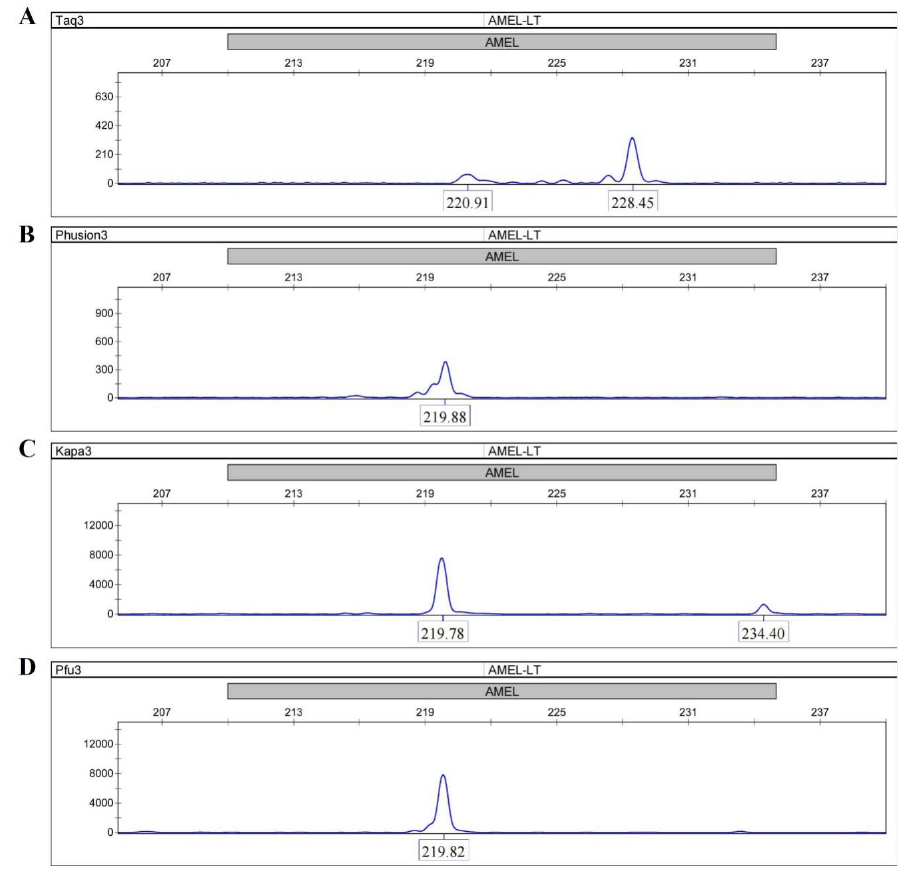
Figure 2. Extensions of TaC primers by the Phusion, Taq, KAPA and Pfu DNA polymerases. ( A ) Taq; ( B ) Phusion; ( C ) KAPA; ( D ) Pfu. Taq gives a main peak at 228.45 bp (full-length) whereas the main peaks in the electropherograms of Phusion, KAPA and Pfu are observed at 219.88 bp, 219.78 bp, and 219.82 bp. The site-specific termination of primer extension can only be successfully achieved in reactions using the three Family B DNA